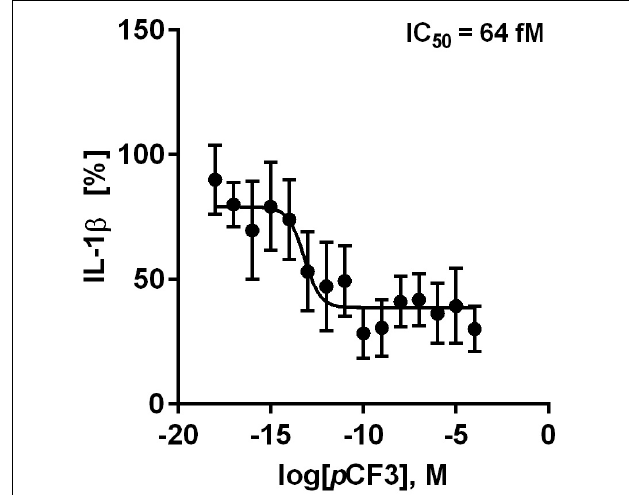
FIGURE 4 | p CF3-diEPP ( p CF3) inhibits the BzATP-mediated release of interleukin-1 β (IL-1 β ) by human peripheral blood mononuclear cells (PBMCs). PBMCs were freshly isolated from blood of healthy human volunteers and primed with lipopolysaccharide (LPS, 5 ng/ml) during the isolation process. After 3 h of culture, non-adherent cells were decanted. p CF3 dose-dependently inhibited the BzATP [2’/3’-O-(4-benzoylbenzoyl)adenosine-5’-triphosphate, tri(triethylammonium) salt] (100 µ M)-induced release of IL-1 β by human PBMCs (IC 50 = 64 fM). The amount of IL-1 β released in response to BzATP was calculated by subtracting the IL-1 β concentrations measured in supernatants of cells treated with LPS alone. In each experiment, the IL-1 β concentration obtained after stimulation with BzATP was set to 100% and all other values were calculated accordingly. IL-1 β (%) is provided on vertical axis and log molar (M) concentrations on horizontal axis. The IC 50 value obtained by the dose-response curve ( n = 5–9 independent experiments, shown as mean ± SEM) was obtained by non-linear regression analysis using Graph Pad Prism 6.0.